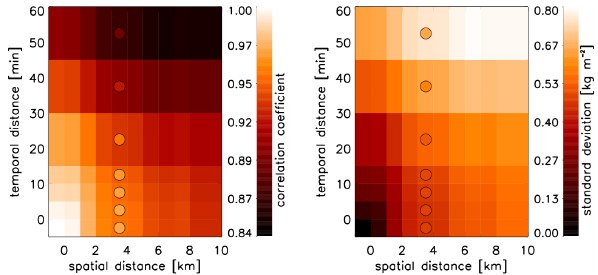
Figure 4. Correlation coefficients (left) and standard deviations (right) of IWV from ICON grid points (simulation for 5 May 2013) as a function of temporal and spatial distance. The circles repre- sent the correlation coefficients and standard deviations from two MWRs positioned 3.3km apart (cf.